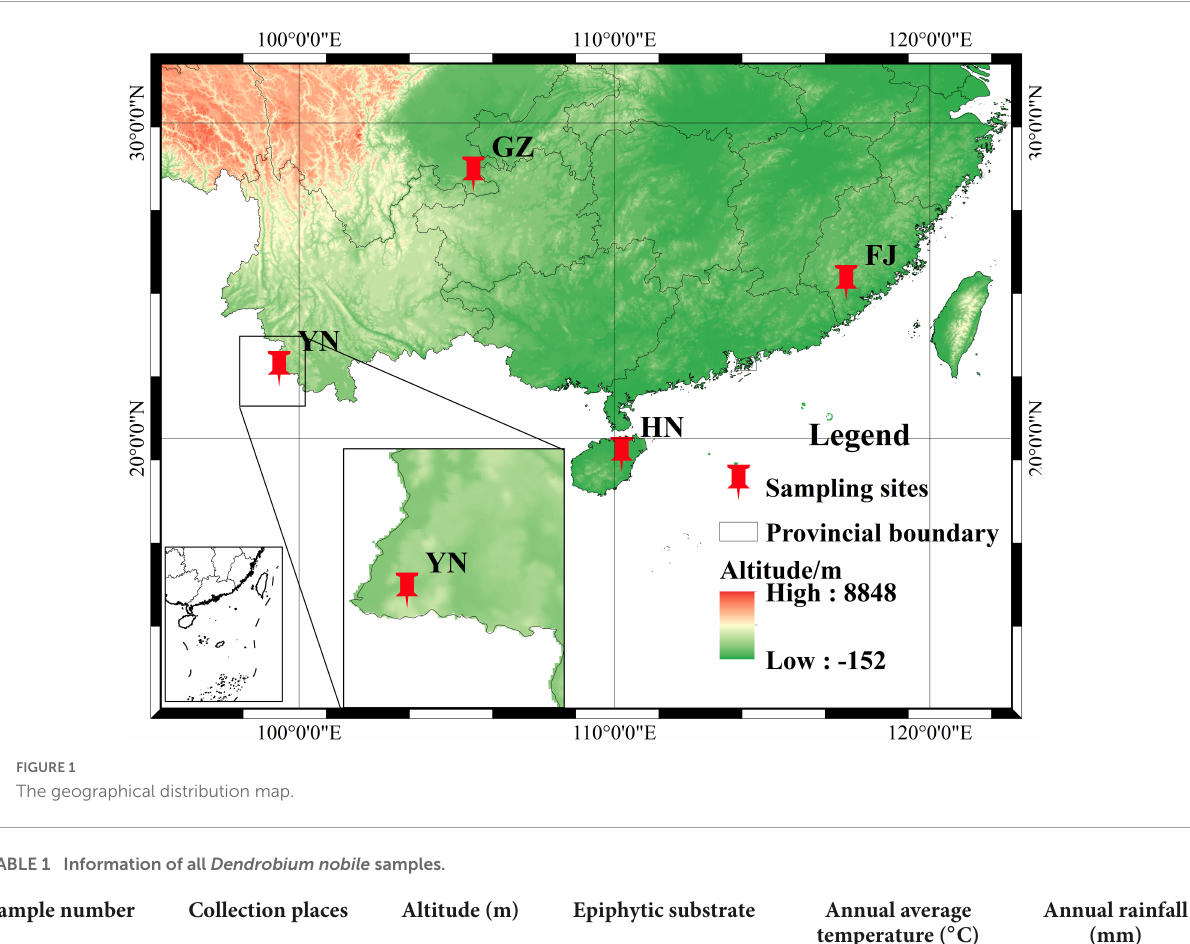
TABLE 1 Information of all Dendrobium nobile